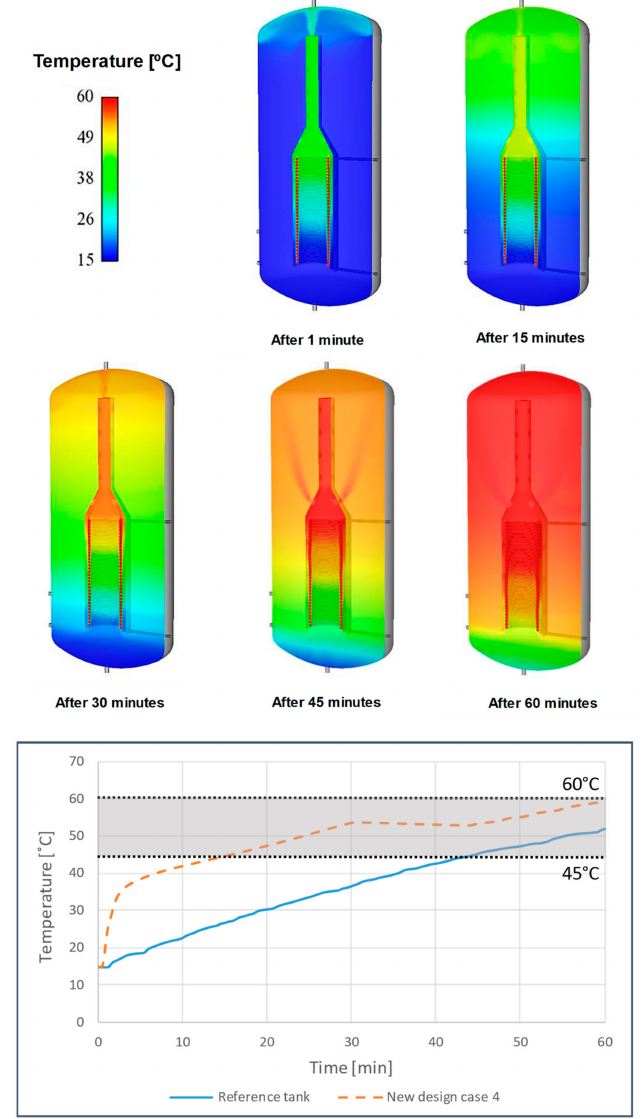
Figure 10. Evolution of the temperature field in simulation 4 and comparison of DHW temperatures with the reference case (average temperature at the DHW